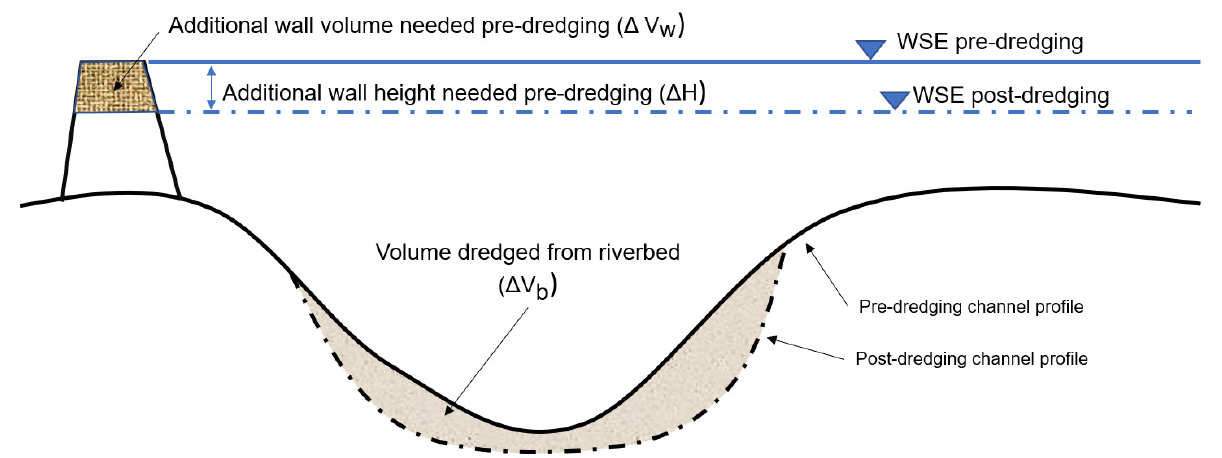
Figure 4. River profile scheme that shows the WSE and channel profile for (i) pre-dredging (continuous line) and (ii) post dredging (dotted line); the additional wall height needed pre-dredging ( Δ H); the additional wall volume pre-dredging ( Δ V w ); and the volume dredged from the riverbed ( Δ V b ).